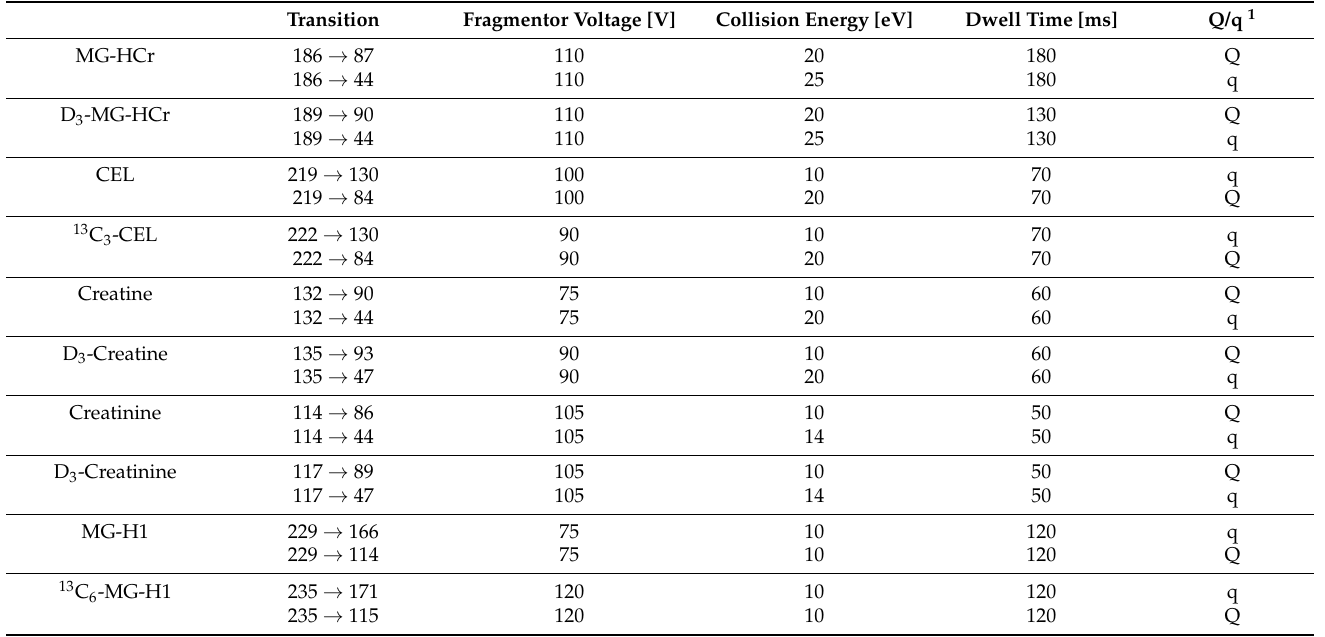
Table 1. Analytes were quantitated by isotope dilution analysis. Table 1. Transitions recorded during MRM